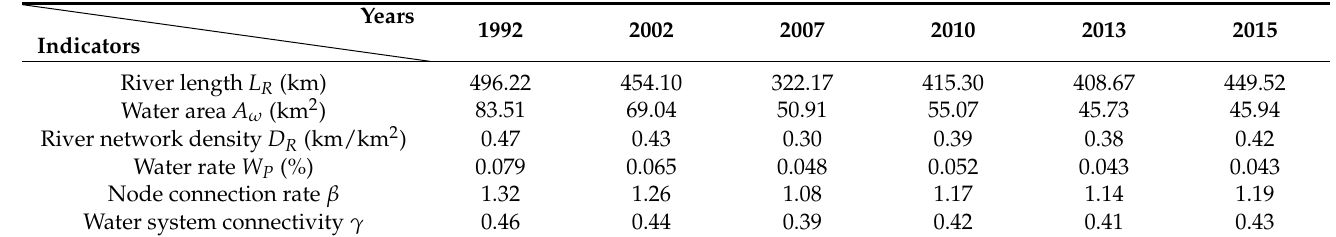
Table 5. Index data of the water system pattern in Zhengzhou.